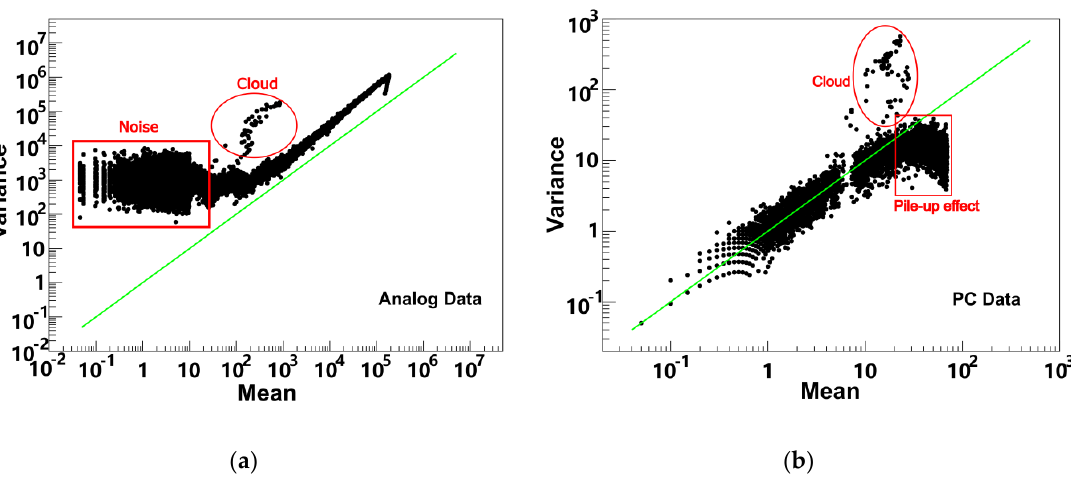
Figure 3. Example of the calculation results of temporal variance for both ( a ) analog data and ( b ) photon-counting data. Fourteen successive probing profiles with a fixed elevation angle of 15 ◦ from the measurements of the ultraviolet elastic scanning lidar were selected as the study objects (profile in Figure 2 is one of the successive 14 events). A green line µ = σ 2 is plotted to show the necessary condition of Poisson property.